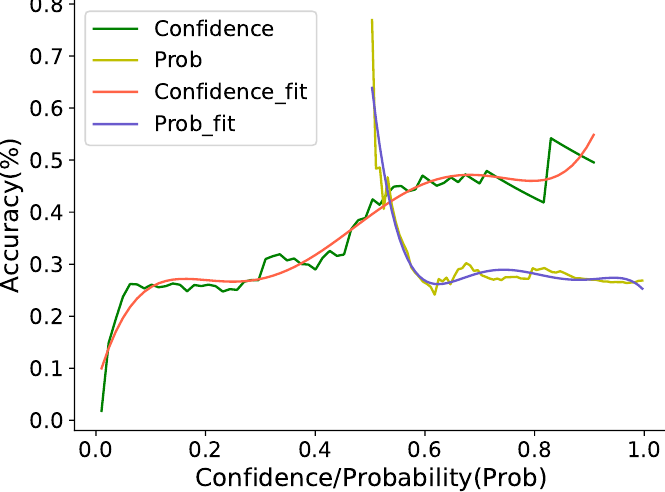
Figure 3. Accuracy of frame-level predictions changes with confidence estimates and probabilities. The accuracy of positive predictions ( prob ≥ 0.5) changed with learned confidence estimations and probabilities. Their polynomial fitting curves are